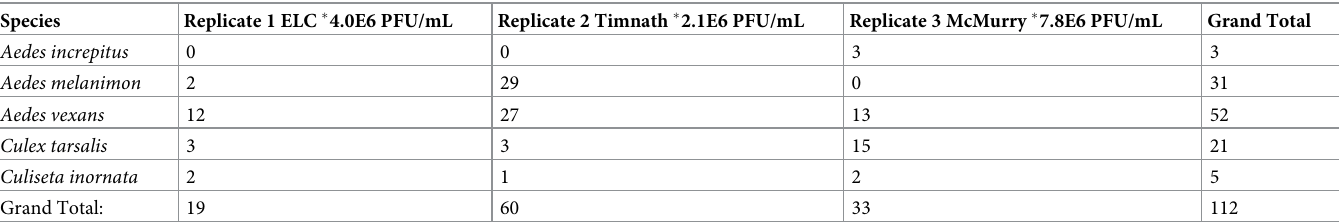
Table 2. Numbers of mosquitoes challenged with RVFV Kenya-128B-15 by species and replicate. � Titer for each blood meal administered to mosquitoes. Species